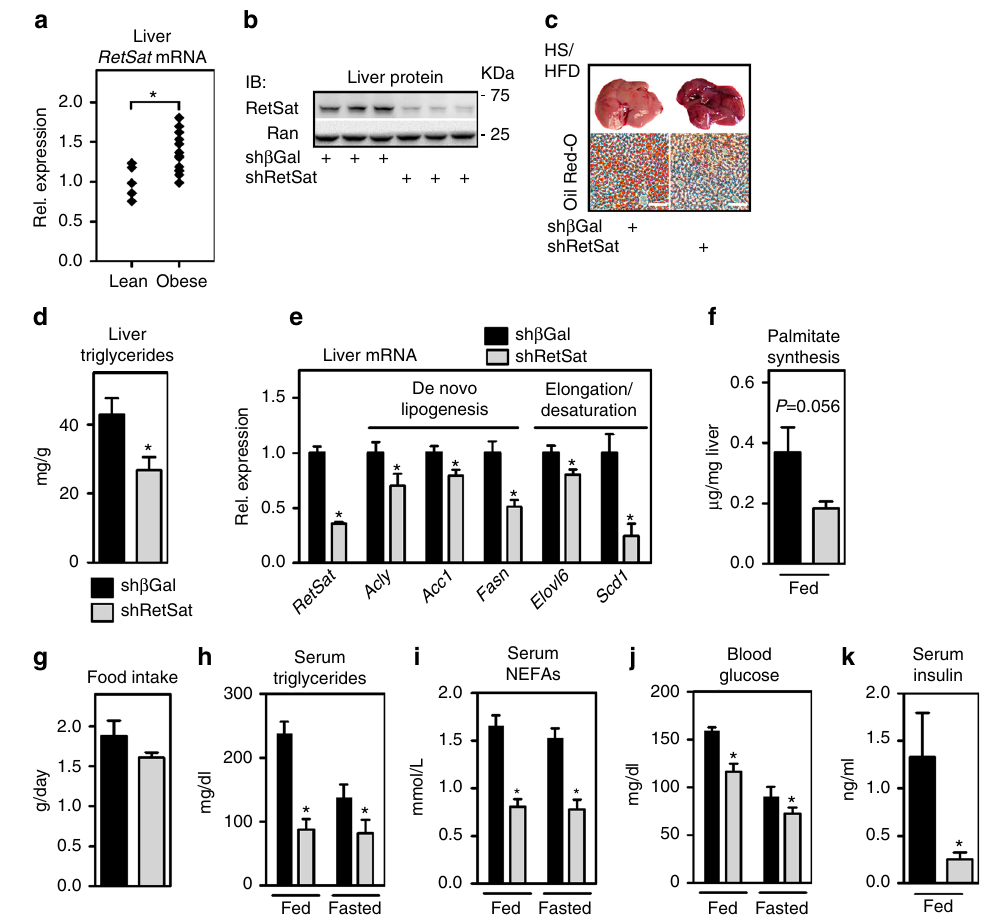
Fig. 2 Hepatic RetSat expression is increased in obese mice and regulates lipid metabolism. a RetSat mRNA expression in livers of lean, NC-fed ( n = 5) and obese, HS/HFD-fed ( n = 13) mice was determined by qPCR. * P < 0.05 between groups by two-tailed t -test. b Mice were injected with adenoviruses expressing shRNA targeting β Gal or RetSat. Six days later, liver protein was analyzed for RetSat protein by immunoblotting. c – j HS/HFD-fed mice were treated as described in b , c liver stained for TGs by Oil Red-O, scale bars = 200 µ M. d Liver TGs in mice were determined biochemically. Data are shown as mean ± s.e.m., n = 12 (sh β Gal), 13 (shRetSat); * P < 0.05 by two-tailed t -test. An independent experiment yielded similar results. e Hepatic mRNA expression of genes involved in lipid metabolism was determined by qPCR. Data are shown as mean ± s.e.m., n = 7 (sh β Gal), 6 (shRetSat); * P < 0.05 by two-tailed t -test. An independent experiment yielded similar results. f Newly synthesized palmitate in liver was assessed by determining the incorporation of deuterated water. Data are shown as mean ± s.e.m., n = 5 (sh β Gal), 5 (shRetSat); P value was determined by two-tailed t- test. g Food intake was measured for two 24 h periods. Data are shown as mean ± s.e.m., n = 6 (sh β Gal), 5 (shRetSat); * P < 0.05 by two-tailed t test. h – j : serum TGs, NEFAs, and blood glucose in ad libitum-fed or 24 h-fasted mice, determined 6 days after virus injection. Data are shown as mean ± s.e.m., n = 13 (sh β Gal), 12 (shRetSat); * P < 0.05 between both groups by two-tailed t- test. An independent experiment yielded similar results. k Serum insulin in ad libitum-fed mice was determined by ELISA. Data are shown as mean ± s.e.m., n = 9 (sh β Gal), 10 (shRetSat); * P < 0.05 by two-tailed t ChREBP staining (Fig. 6a). In hepatocytes depleted of RetSat RetSat depletion reduces ChREBP activity. Indeed, a carbohydrate (Supplementary Fig. 5b), nuclear accumulation of ChREBP upon response element (ChoRE)-driven luciferase reporter 33 , showing high glucose was blunted (Fig. 6a, arrows, and quanti fi cation in the expected induction by high glucose, was less active in RetSat- Fig. 6b). We then asked whether the putative enzymatic product depleted hepatocytes (Fig. 5d). Moreover, ChREBP target genes 13,14-dhretinol can compensate for impaired ChREBP responses matched this activity pattern in primary hepatocytes when due to RetSat depletion. Surprisingly, neither the reduced exposed to either low or high glucose concentrations (Fig. 5e). induction of ChREBP target genes (Fig. 6c) nor lower de novo lipogenesis (Fig. 6d) were rescued by providing 13,14-dhretinol, RetSat depletion impairs the nuclear accumulation of suggesting that dhretinol formation is not the enzymatic reaction ChREBP . Upon exposure to high glucose concentrations, cyto- required for ChREBP ’ s activity. We next asked whether a lack of solic ChREBP translocates and accumulates in the nucleus 34 . glucose metabolites could be responsible for reduced ChREBP After validating the ChREBP antibody for immuno fl uorescence activity and found that RetSat-depleted cells contained higher levels of certain glycolytic and pentose phosphate pathway staining, Supplementary Fig. 5a), we compared the nuclear signal metabolites, including glucose 6-phosphate and sedoheptulose 7- phosphate (Supplementary Fig. 6). This argues against a primary exposed to low or high glucose concentrations. Insulin was added defect in the generation of ChREBP-activating glucose metabo- lites in RetSat-depleted hepatocytes. Interestingly, increased